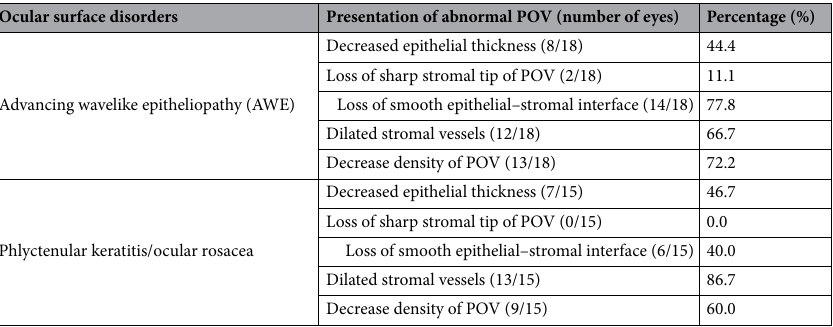
Table 2. Presentations of the abnormal POV at the most severe lesion sites of the diseased eyes evaluated through SD-OCT. POV palisades of Vogt, SD-OCT spectral-domain optical coherence tomography.